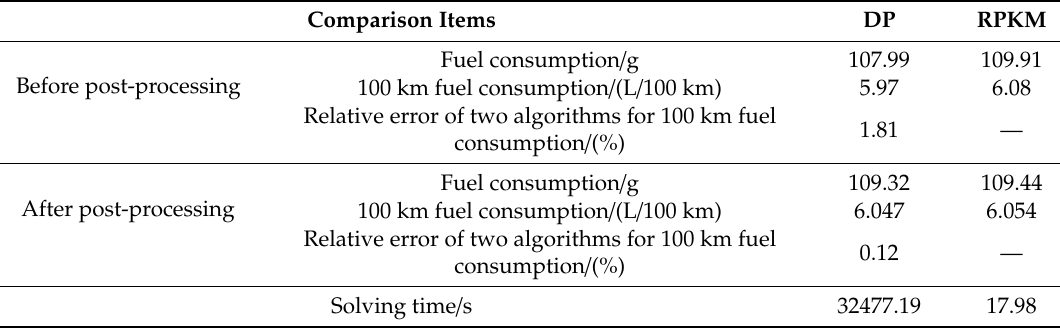
Table 3. Comparison of optimization results between DP and